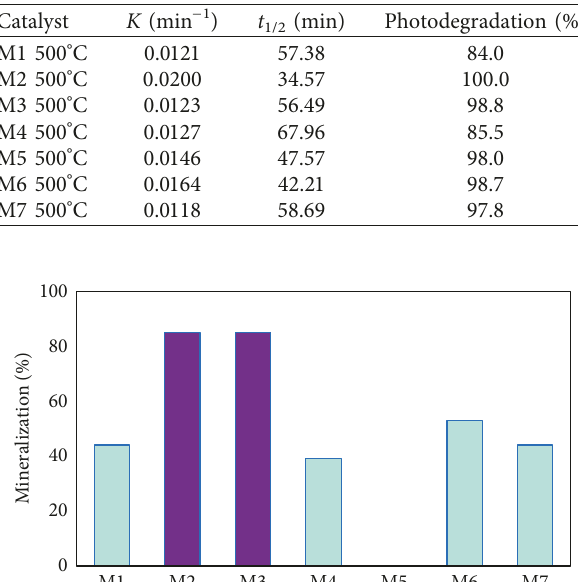
Table 5: Kinetic parameters after 2 hours of reaction time.